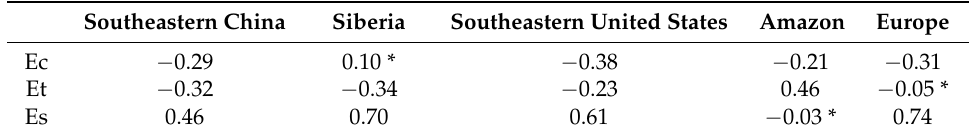
Figure 10. Spatial distribution of global latent heat flux (units: W/m 2 ): ( a – d ) FLUXNET data and ( e – h ) simulated by CLM4.5. Table 6. The temporal correlation coefficient of the bias between latent heat flux and its components in some problematic regions (* indicates not pass significance test at significance level of